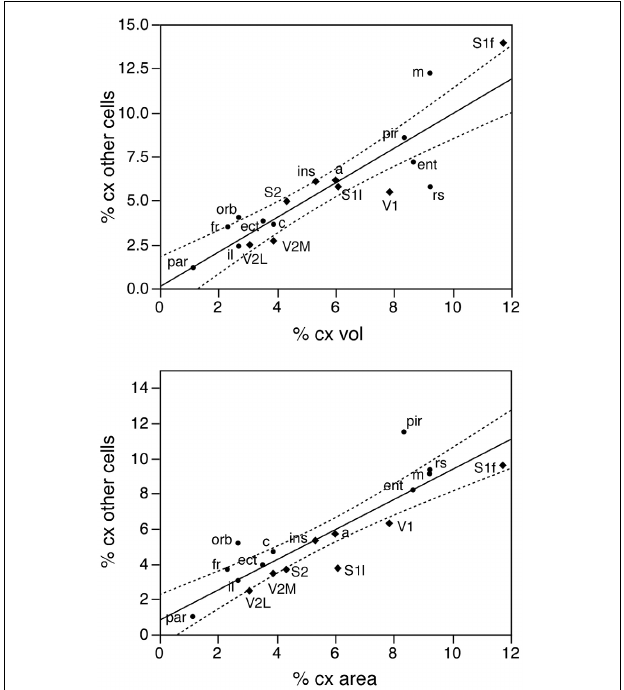
FIGURE 8 | The relative number of cortical other cells found in each functional area correlates well with both the relative volume and the relative surface area of each functional area. Top, relative number of cortical other cells in each area plotted as a function of the relative volume of that functional area. Bottom, relative number of cortical other cells in each area plotted as a function of the relative surface area of that functional area. The fitted lines are the linear functions that describe the entire dataset; the 95% confidence intervals are indicated by the dotted lines.